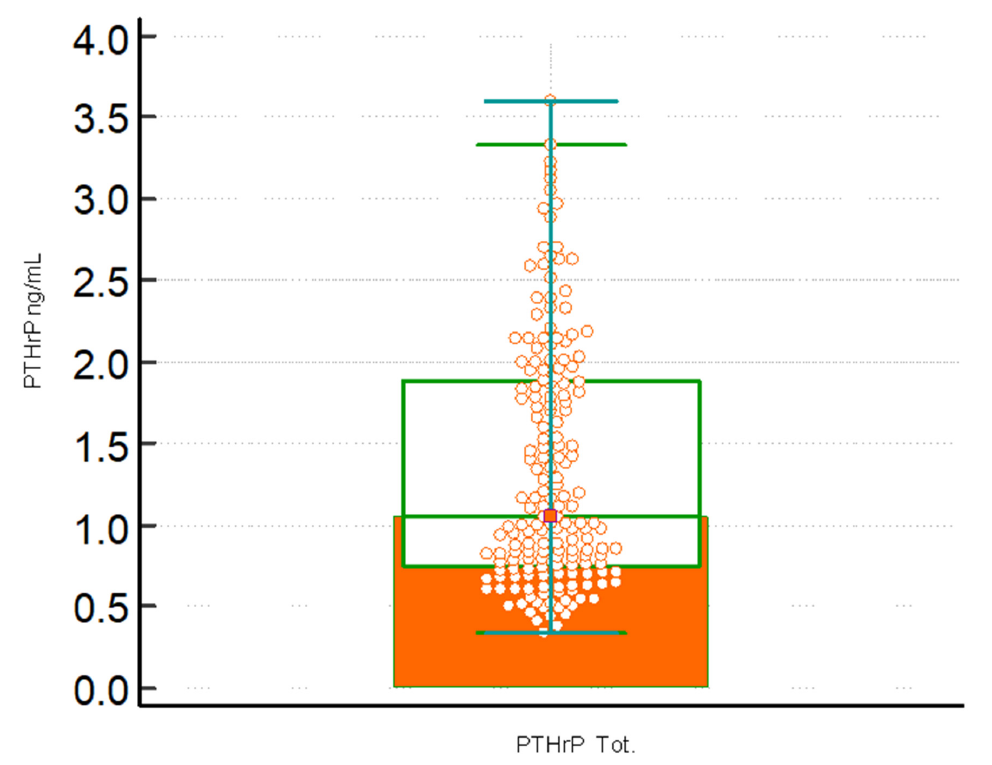
Figure 2. Boxplot with the statistical summary of the concentration of PTHrP (ng/mL) obtained on the total of the subjects evaluated (PTHrP Tot.). The central box shows the values from the 25th to the 75th quartile, the central line the median, the horizontal lines the extension from the minimum to the maximum value (range). A possible outside is